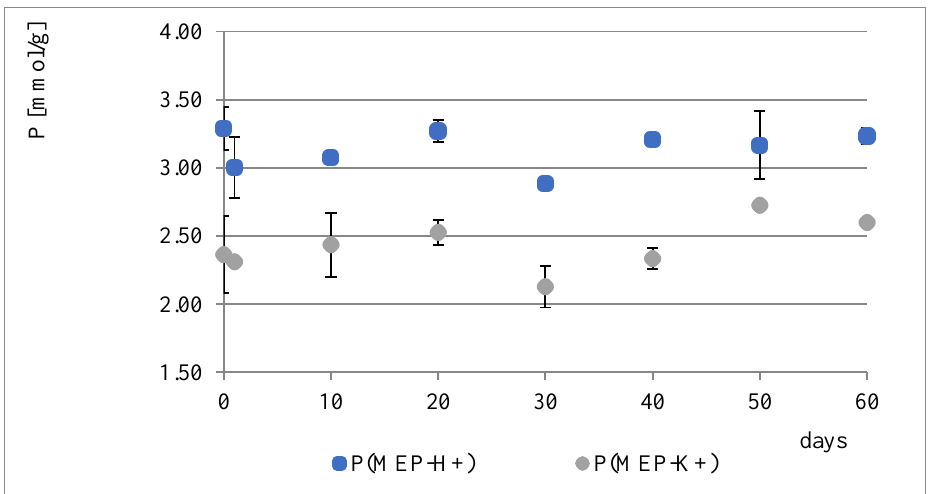
Figure 5. Phosphorus content changes in PMEP over a two-month period.